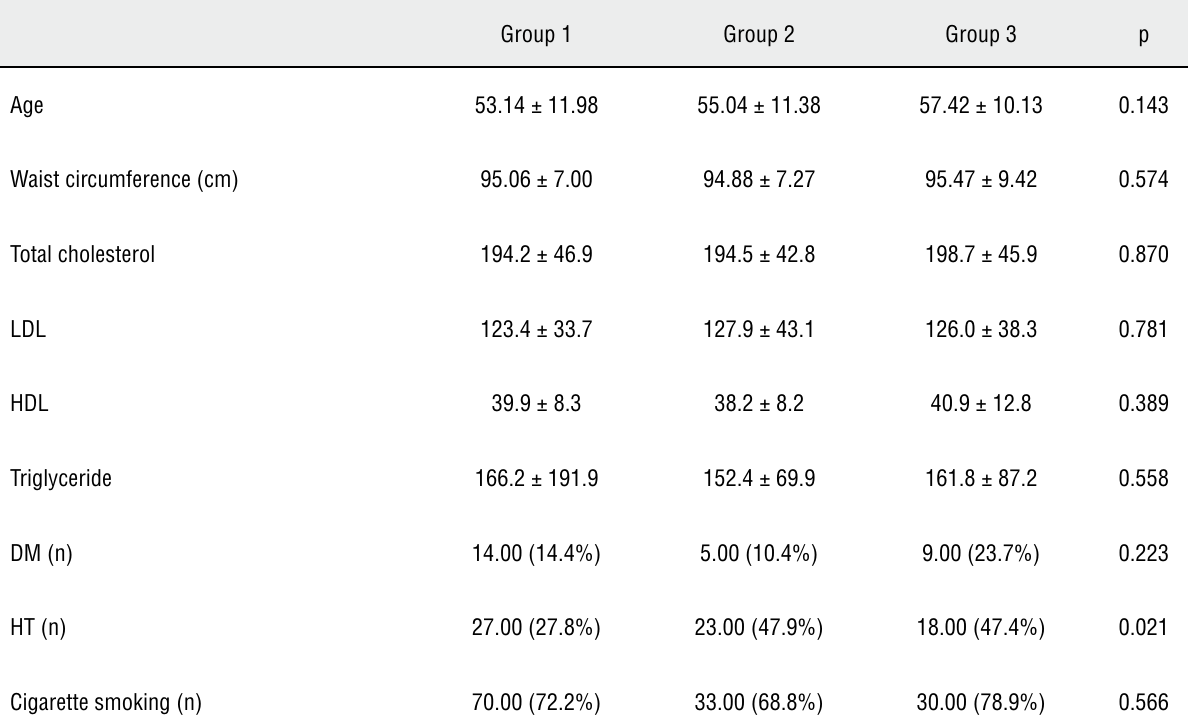
Table 1 - Demographic characteristics of the